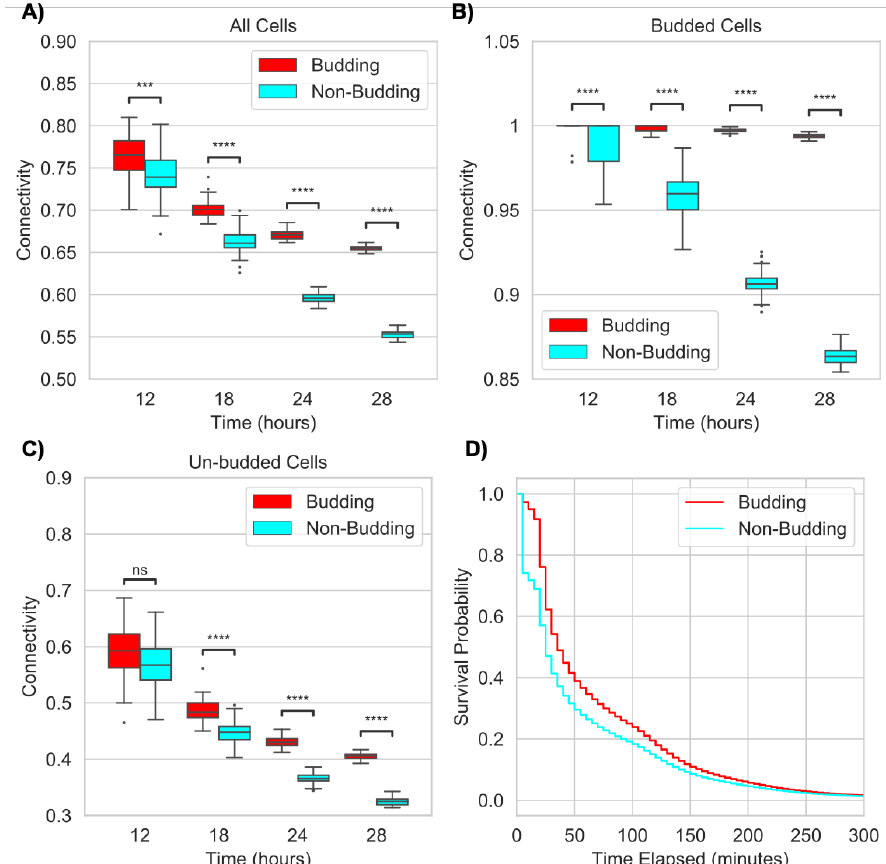
Figure 9. Colony Connectivity in Nutrient-Limited Colonies. Comparison of colony connectivity between budding and non-budding colonies in nutrient-limited conditions at 12 h, 18 h, 24 h and 28 h. We compared connectivity for all cells in ( A ), as well as cells in two distinct phases: during the time when cells are attached for budding colonies in ( B ) and after separation in ( C ). (See Section 4.2.2 for how we define connectivity.) ( A ) We observe a statistically significant difference in colony connectivity at 12 h ( p = 3.602 × 10 − 04 ), 18 h ( p = 8.921 × 10 − 29 ), 24 h ( p = 1.094 × 10 − 79 ) and 28 h ( p = 3.389 × 10 − 110 ). ( B ) We observe a rapid decrease in connectivity for non-budding colonies between 12–18, 18–24, and 24–28 h. This decrease leads to a statistically significant difference between budding and non-budding colonies at 12 h ( p = 6.834 × 10 − 05 ), 18 h ( p = 4.670 × 10 − 40 ), 24 h ( p = 1.050 × 10 − 92 ) and 28 h ( p = 2.658 × 10 − 122 ). ( C ) We observe a statistically significant difference in connectivity at 18 h ( p = 1.144 × 10 − 15 ), 24 h ( p = 1.888 × 10 − 58 ) and 28 h ( p = 2.140 × 10 − 83 ). ( p -values for connectivity were computed using independent t -tests. p -value annotation is as follows. *: 1.0 × 10 − 2 p ≤ 5.0 × 10 − 2 , **: 1.0 × 10 − 3 p ≤ 1.0 × 10 − 2 , ***: 1.0 × 10 − 4 p ≤ 1.0 × 10 − 3 , ****: p ≤ 1.0 × 10 − 4 .); ( D ) Kaplan-Meier survival curves for the edge connecting mother-daughter cell pairs in G S for budding (red) and non-budding (blue) colonies. The y -axis is the probability that a given mother-daughter edge will remain in G S for longer than t hours after separation, where time is on the x -axis. We observe that the survival curves are different between the two groups ( p = 1.314 × 10 − 75 ) indicating that the probability that a mother-daughter edge remains in the spatial graph for longer than t hours is greater for budding colonies. (The p -value comparing survival curves was calculated using a log-rank test as described in Section 4.3. See Section 2.2.3 for